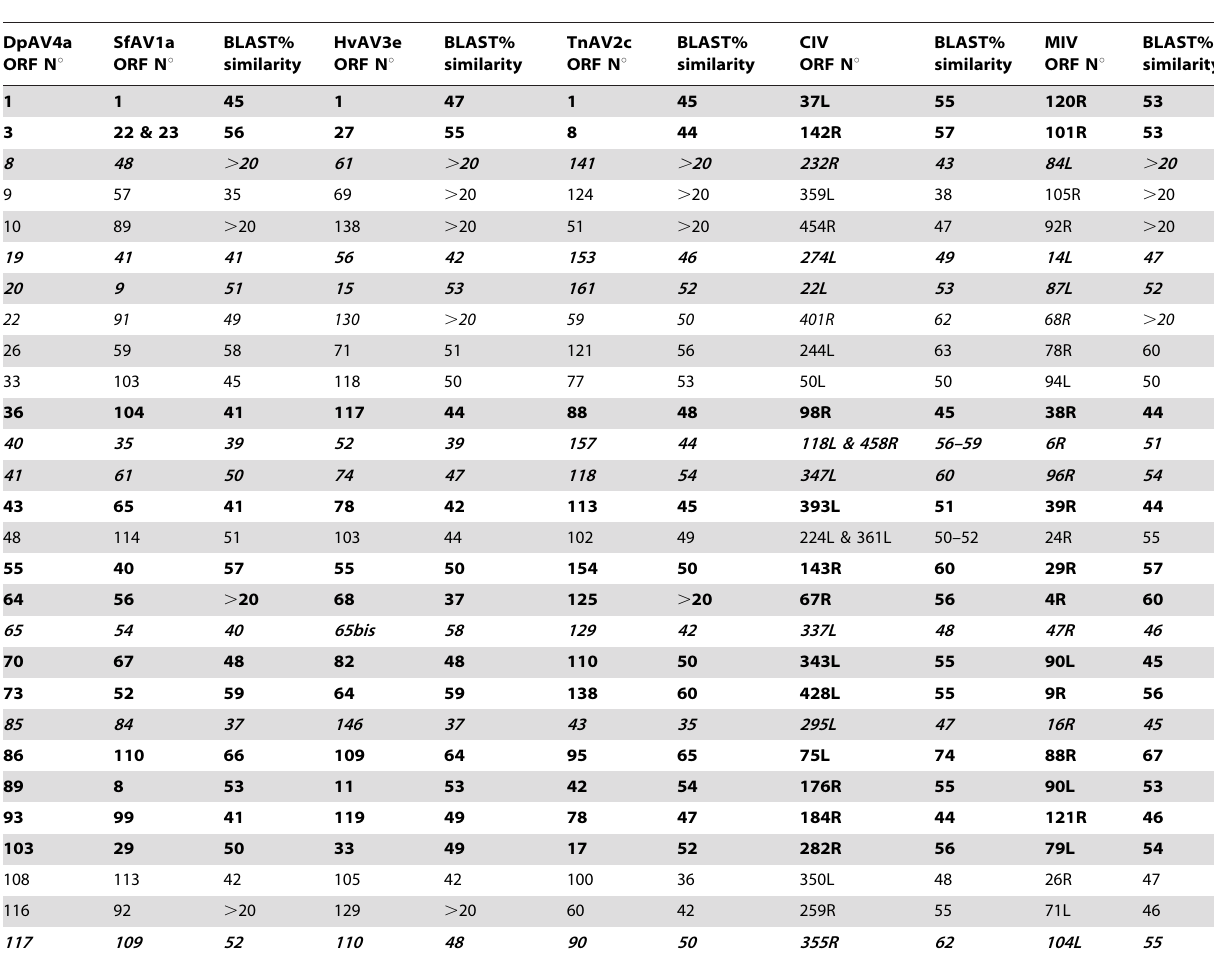
Table 1. Core genes common to the genomes of four ascoviruses and two invertebrate iridoviruses sequenced to